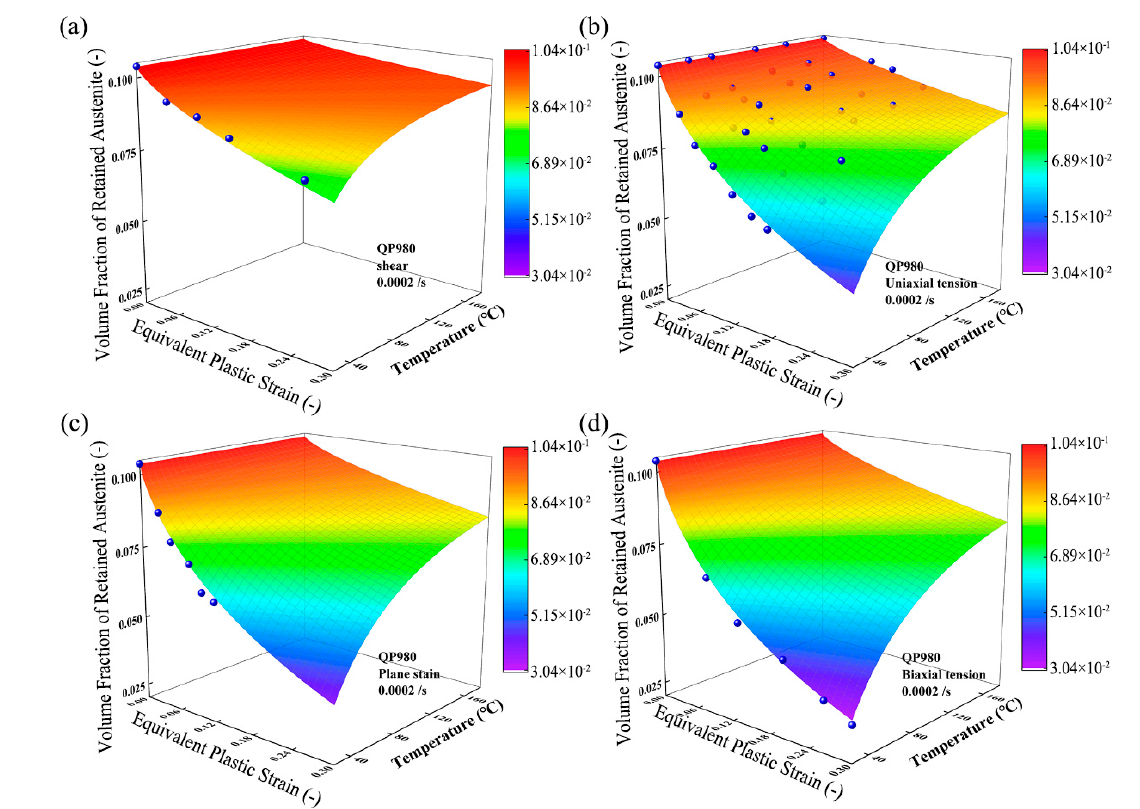
Figure A1. Retained austenite evolution with EPS and temperature in various stress conditions: ( a ) shear; ( b ) uniaxial tension; ( c ) plain strain; ( d ) biaxial tension (The blue balls are the experimental data).